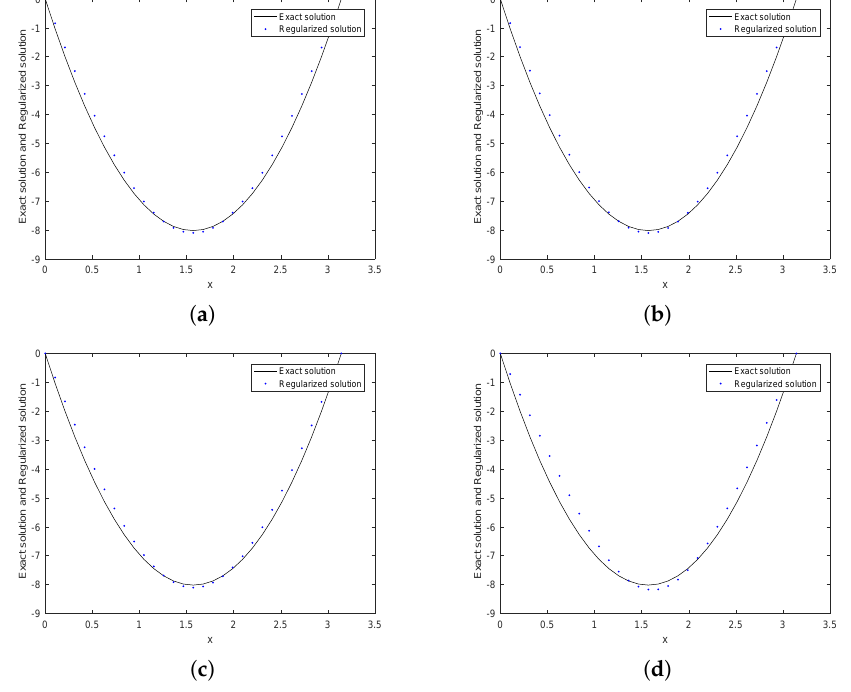
Figure 2. k = 1.5, γ = 2, q = 4; Exact and Regularized solutions for various ε . ( a ): ε = 0.001, ( b ): ε = 0.01, ( c ): ε = 0.05, ( d ): ε =